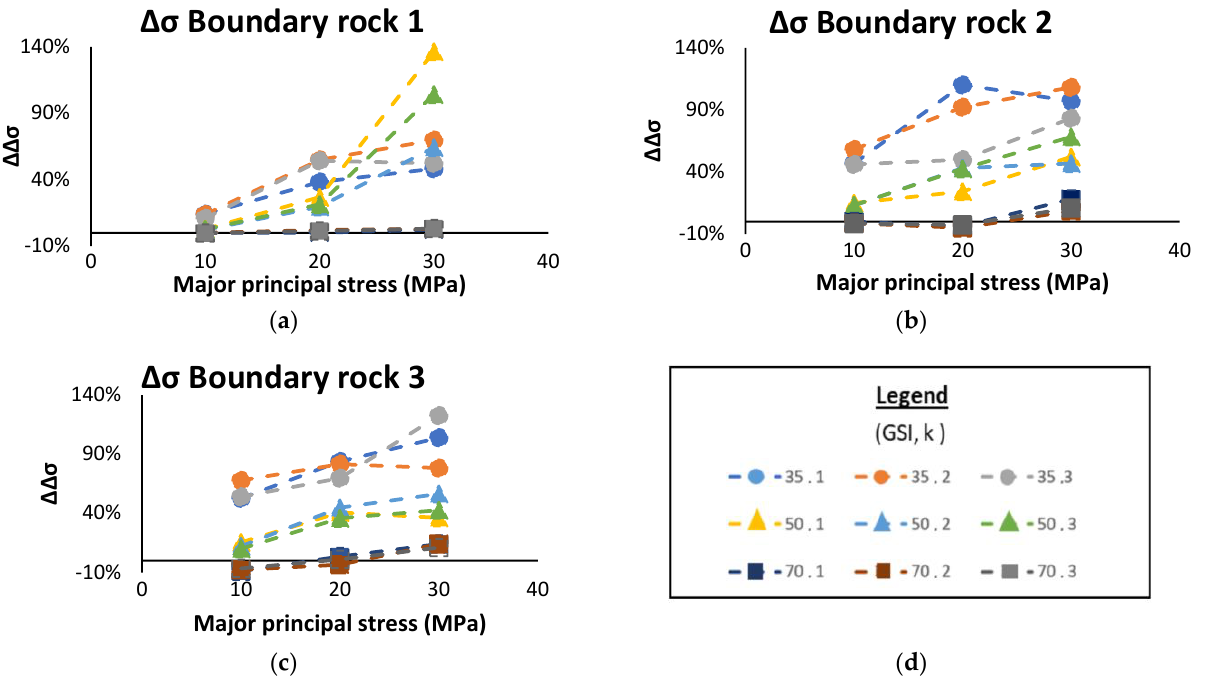
Figure 12. Variation of the relative deviation of the maximal differential stress at the boundary of the excavation as the major principal stress increases, ( a ) boundary rock 1, ( b ) boundary rock 2, ( c ) boundary rock 3, ( d ) legend.